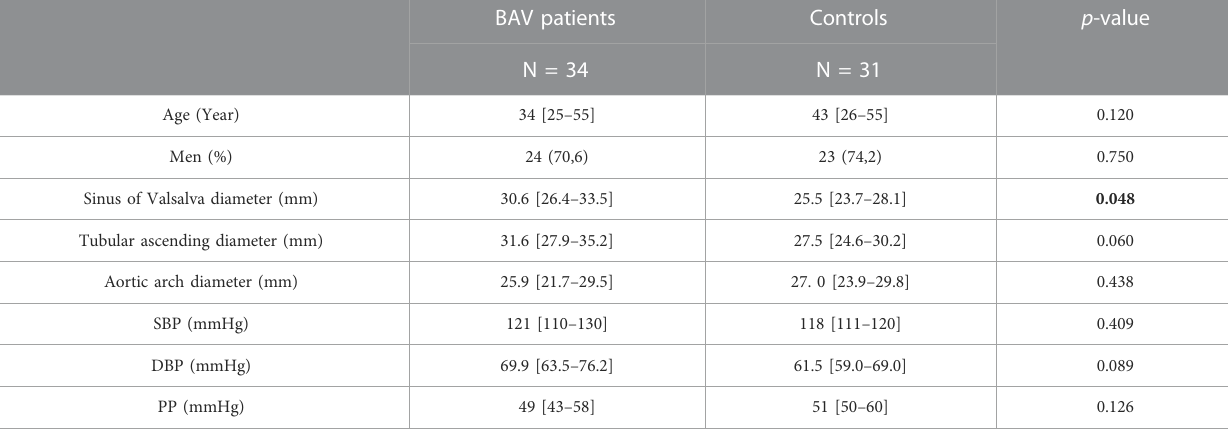
TABLE 1 Characteristics of BAV patients and controls. BAV: bicuspid aortic valve; DBP: diastolic blood pressure; SBP: systolic blood pressure; PP: pulse pressure (SBP – DBP). p -values are obtained from the Mann-Whitney test. Data in bold correspond to statistically signi fi cant comparisons ( P < 0.05).